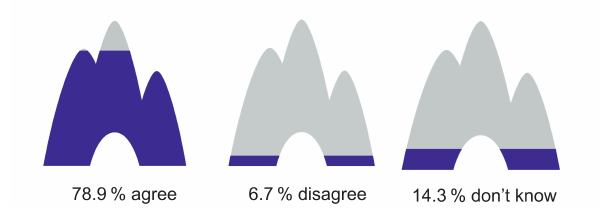
Figure 6. Attitudes of questionnaire respondents ( n = 223) to the statement “water naturally forms channels underground in order to flow through